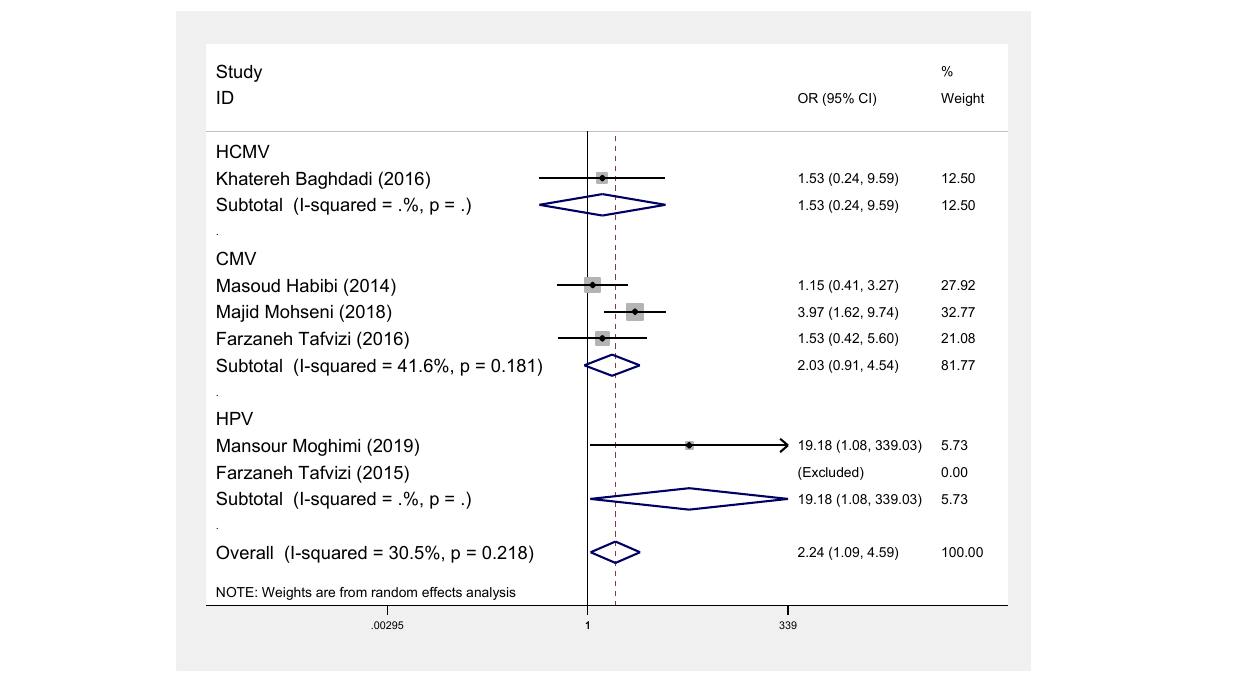
Funnel plot with pseudo 95% confidence limits